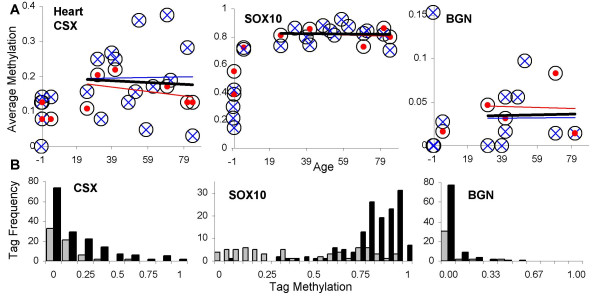
Heart tag methylation. A: Tag methylation with chronological aging. Circles are averages of eight tags with red solid dots from the right heart, and blue X's from the left heart. Trend lines (black, all values; red, right heart; blue, left heart) were not significantly different from a level line (linear regression, p values > 0.05). B: Histograms of individual tags comparing individuals before heart growth is largely finished (≤ 5 years of age, gray bars, N = 64, 63, and 37 alleles for CSX, SOX10, and BGN tags) and adults (black bars, N = 161, 143, and 94 alleles for CSX, SOX10, and BGN tags). CSX or SOX10 tag methylation values were significantly higher in adults.